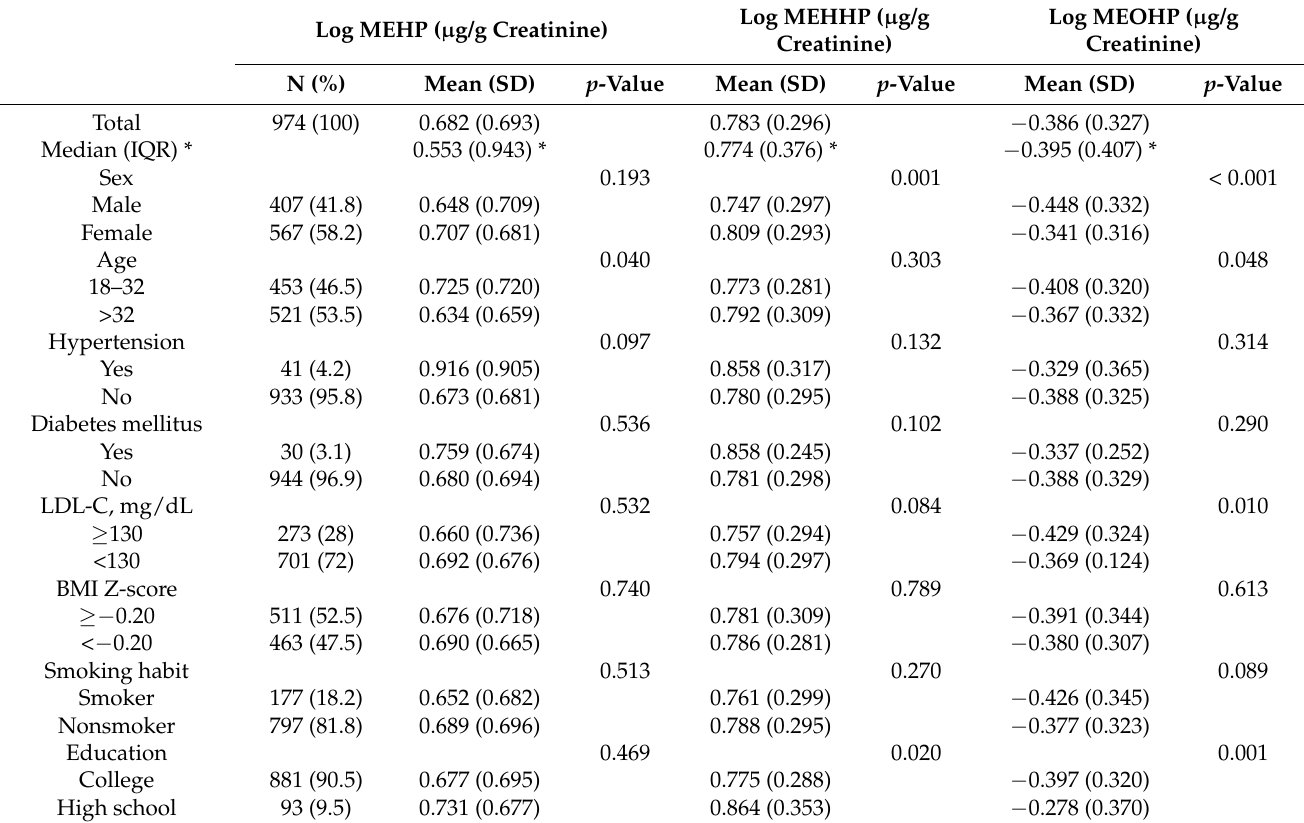
Table 1. Basic demographics and subgroup analysis of urinary phthalate